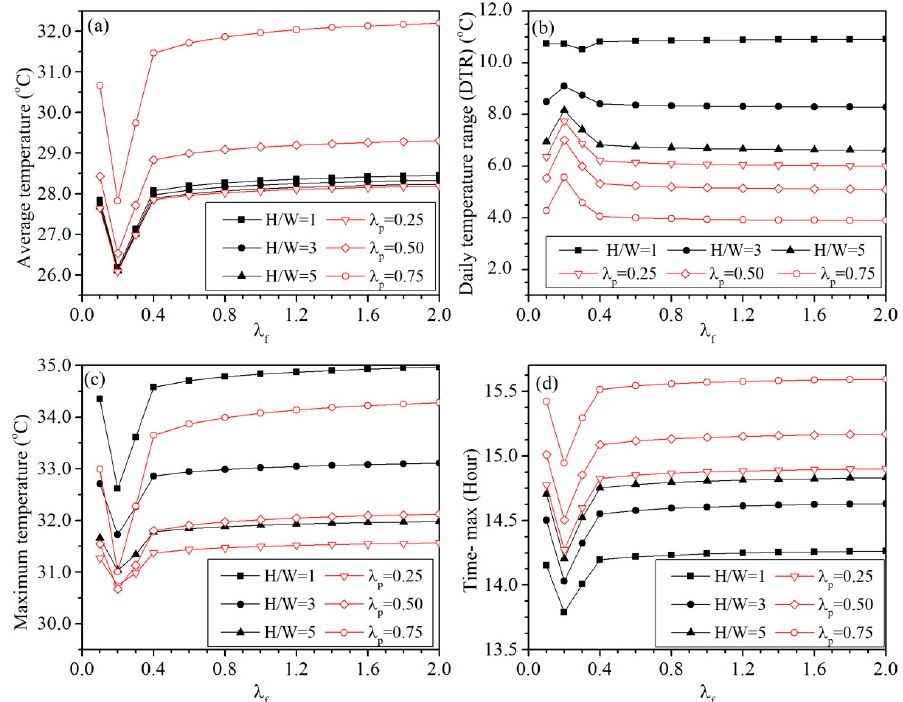
Figure 15. ( a ) The average air temperature; ( b ) the diurnal temperature range; ( c ) the maximum air temperature; and ( d ) the time when the maximum temperature appears of the diurnal temperature with different H/W ratio, plan area ratio ( p ) and frontal area ratio ( f ). Finally, these parameters together also influence the anthropogenic heat from buildings, and the effect of all of them is rather complicated for analyses. We categorized five scenarios that are commonly found in existing cities. The parameters of these five scenarios are shown in Table 4. Assuming the total control volume and plan area is the same among the five scenarios, the average building height changes due to changes in the urban morphology parameters. Scenario 1 is the low- rise low-density city, which is low and sparse, referred to as LS; Scenarios 2 and 3 are high-rise low- density city with different height and H/W ratio, which is high and sparse, referred to as HS; Scenario 4 is low-rise high-density city, which is low and compact, referred to as LC; and Scenario 5 is high- rise high-density city, which is high and compact, referred to as HC. Meanwhile, since the height of the building is not the same, the anthropogenic heat generated from buildings are different according to Equation (16).